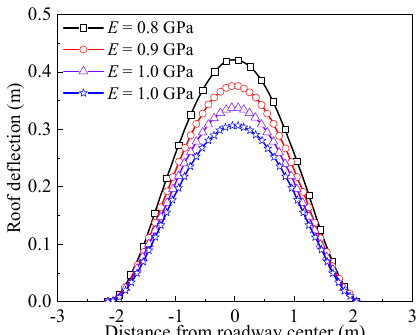
Figure 10. Relationship between composite roof deflection and rock strength.It can be seen from Figure 10 that with the increase of rock elastic modulus, the maximum deflection of mudstone stratifi- cation is accelerating and decreasing. Therefore, when the composite roof remains intact, the bearing capacity is strong, but the composite roof is damaged and its bearing capacity decreases